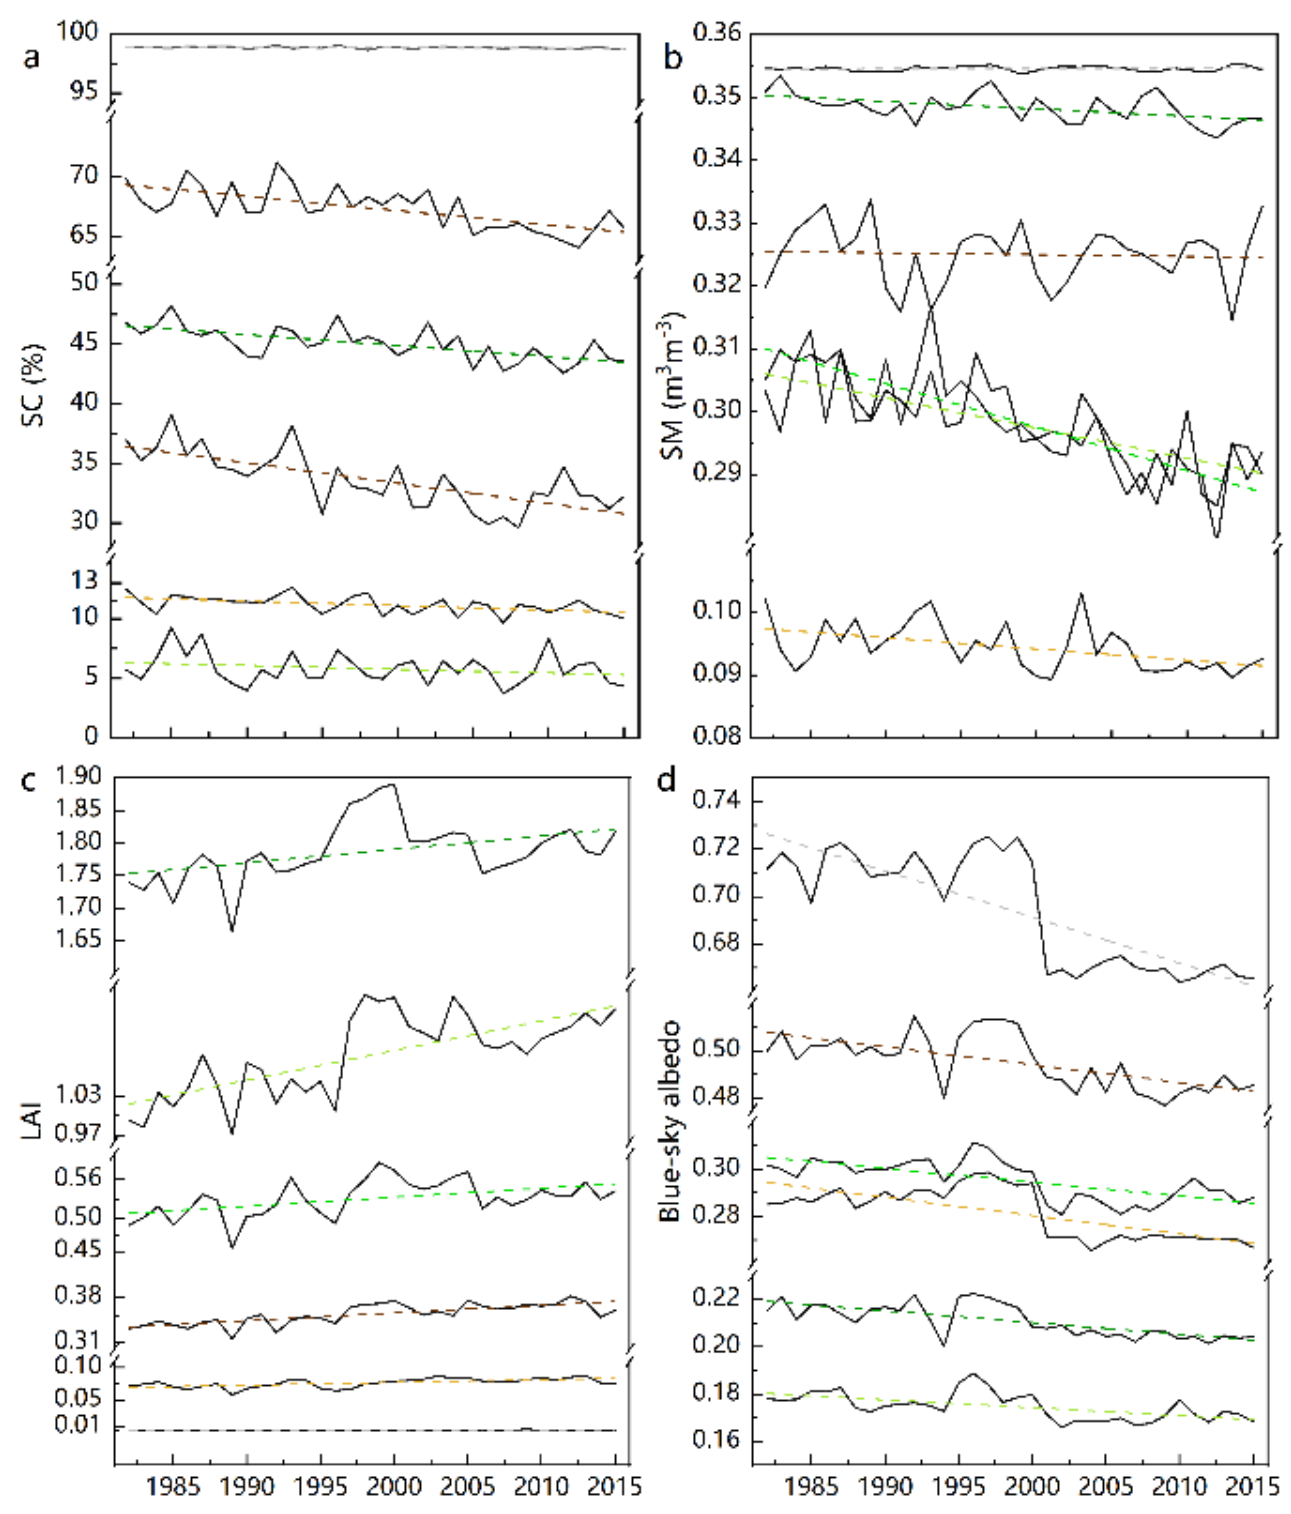
Figure 4. The trends of annual mean SC ( a ), SM ( b ), LAI ( c ) and blue-sky albedo ( d ) for the entire study area and different land cover types, with colors of fitting lines corresponding to the colors in the legend in the Figure 1 (a).